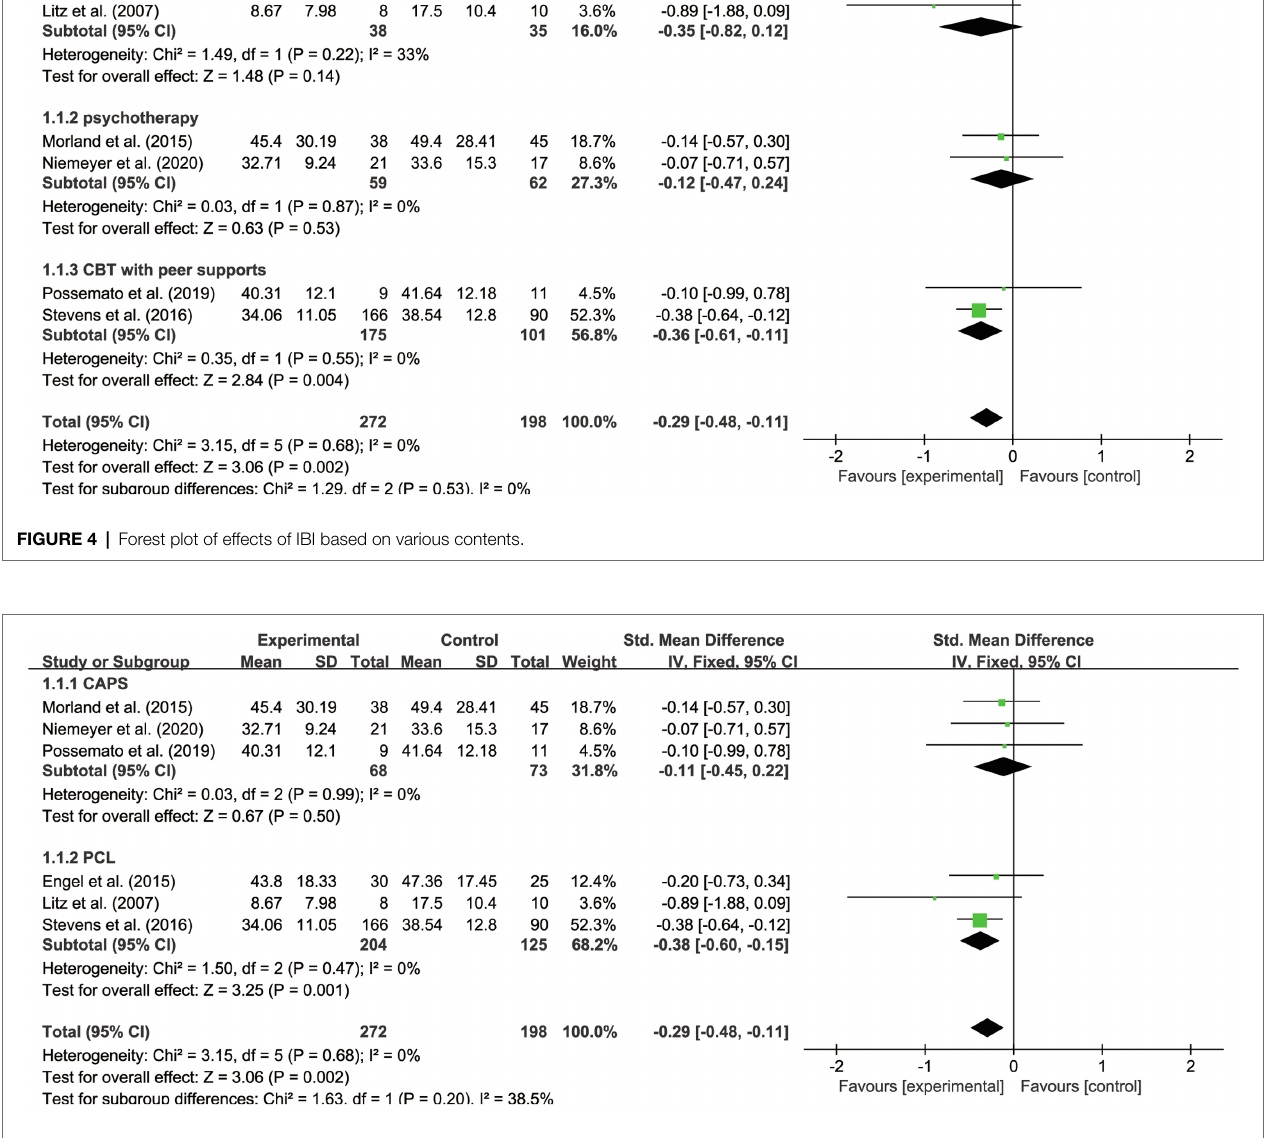
FIGURE 5 | Forest plot of effects of IBI on PTSD with different